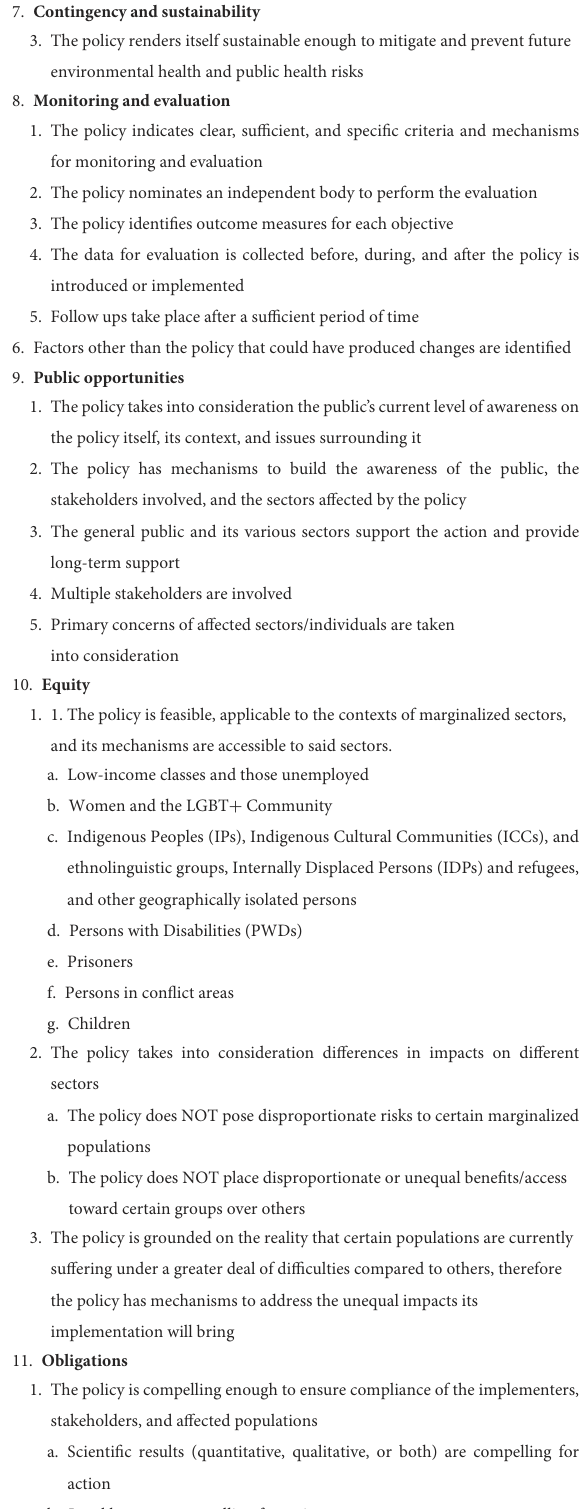
TABLE 2 Modified criteria for analyzing COVID-19 waste management